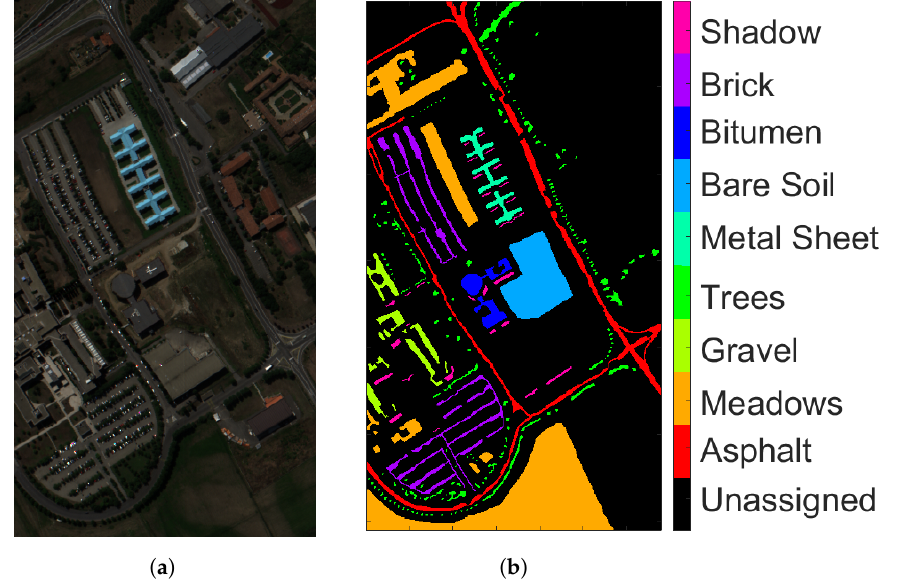
Figure 2. ROSIS Pavia University ( a ) true-color composite; ( b ) reference class map. Table 1. Groundtruth classes for PU scene and their respective samples